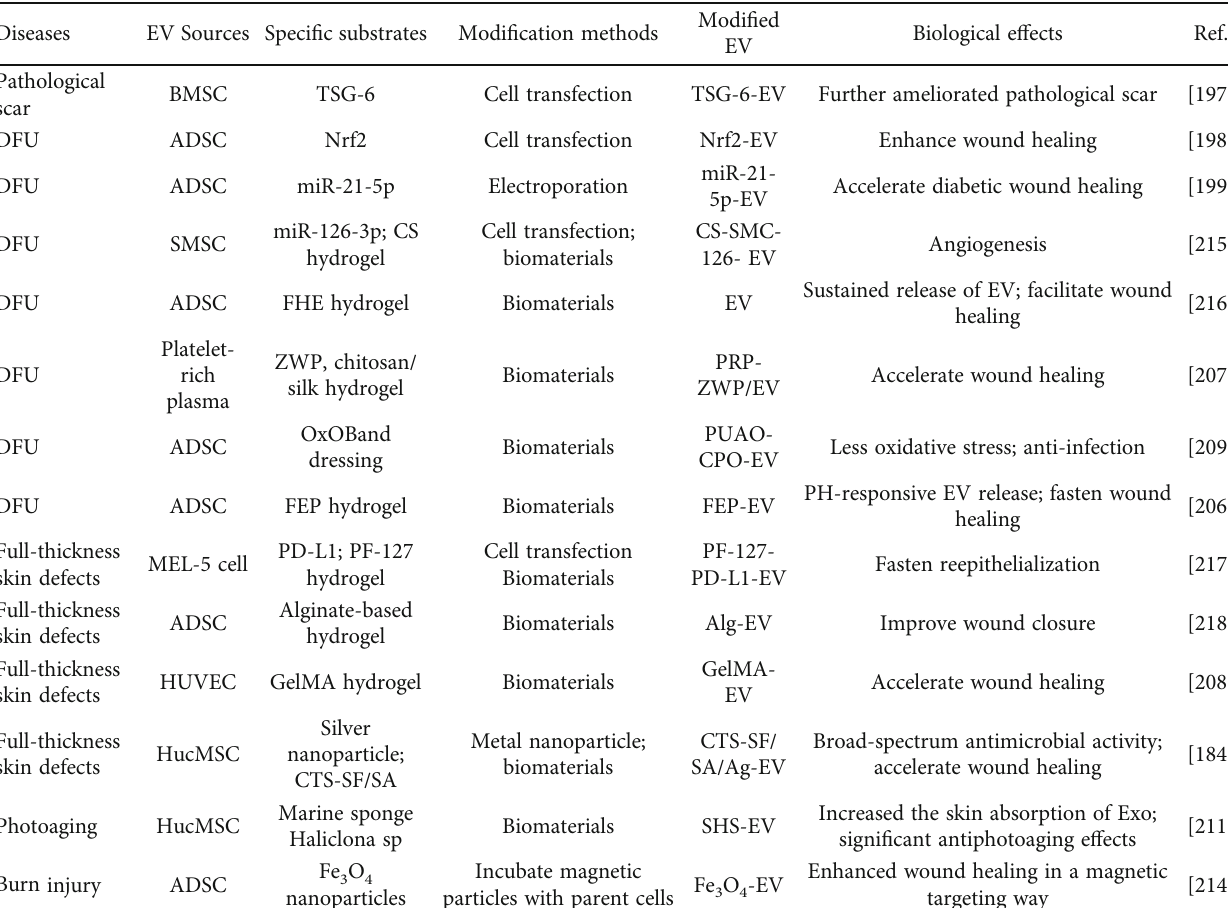
Table 9: Modi fi ed EVs in the therapy of skin